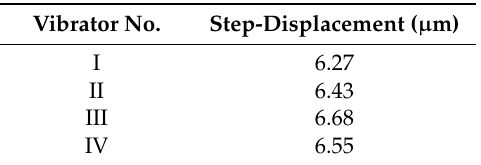
Table 3. The step-displacements of the four vibrators.